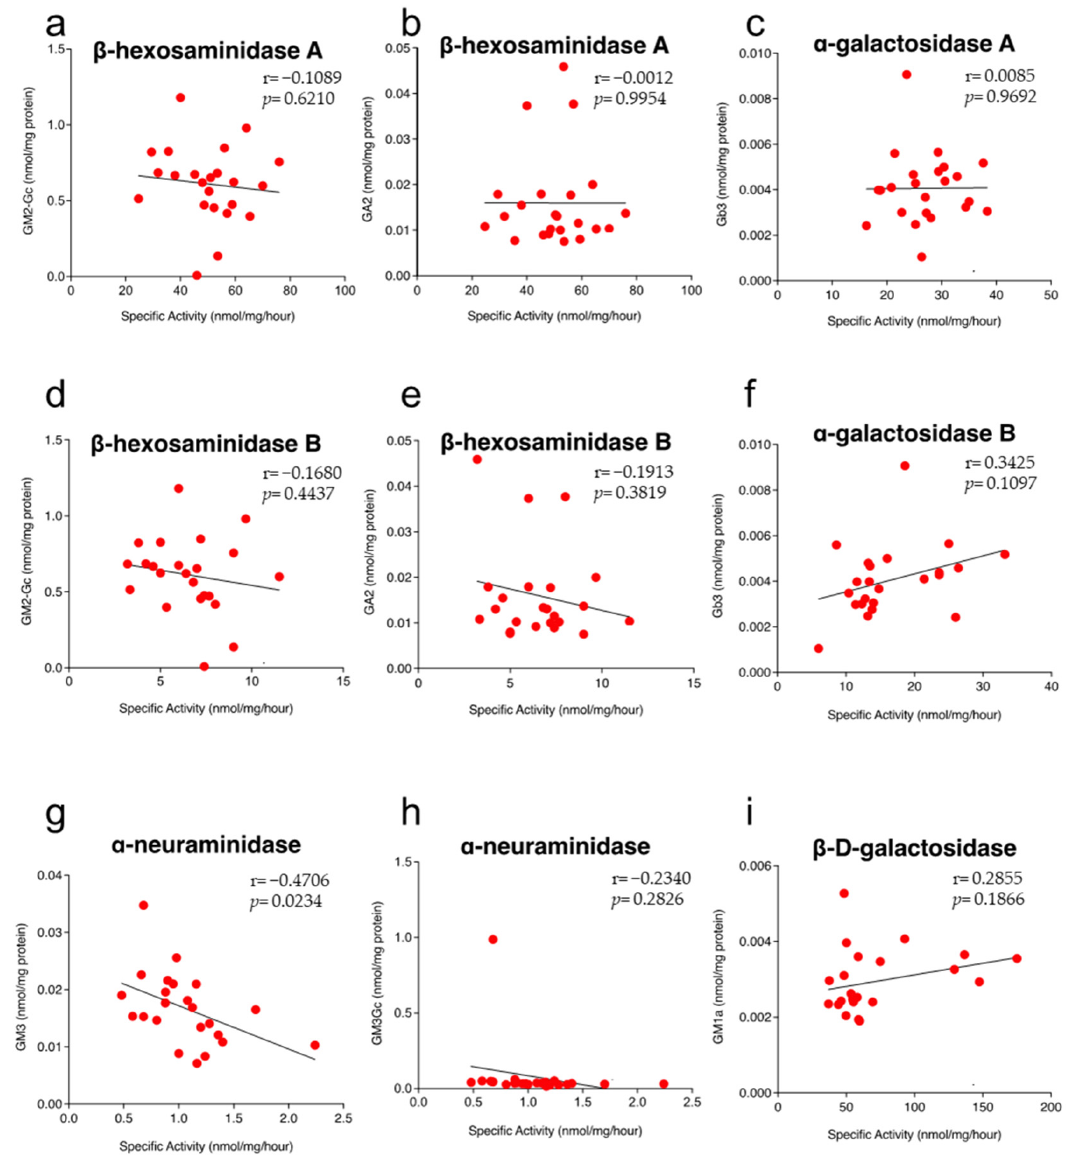
Figure 5. Correlation of hepatic lysosomal enzyme activities and specific substrates levels. Each dot represents a mouse strain. ( a ) HexA vs. GM2-Gc. ( b ) HexA vs. GA2. ( c ) α -Gal A vs. Gb3. ( d ) HexB vs. GM2-Gc. ( e ) HexB vs. GA2. ( f ) α -Gal B vs. Gb3. ( g ) Neu vs. GM3. ( h ) Neu vs. GM3-Gc. ( i ) β -D-Gal vs. GM1a; r, Pearsons’ correlation; p , p -value.